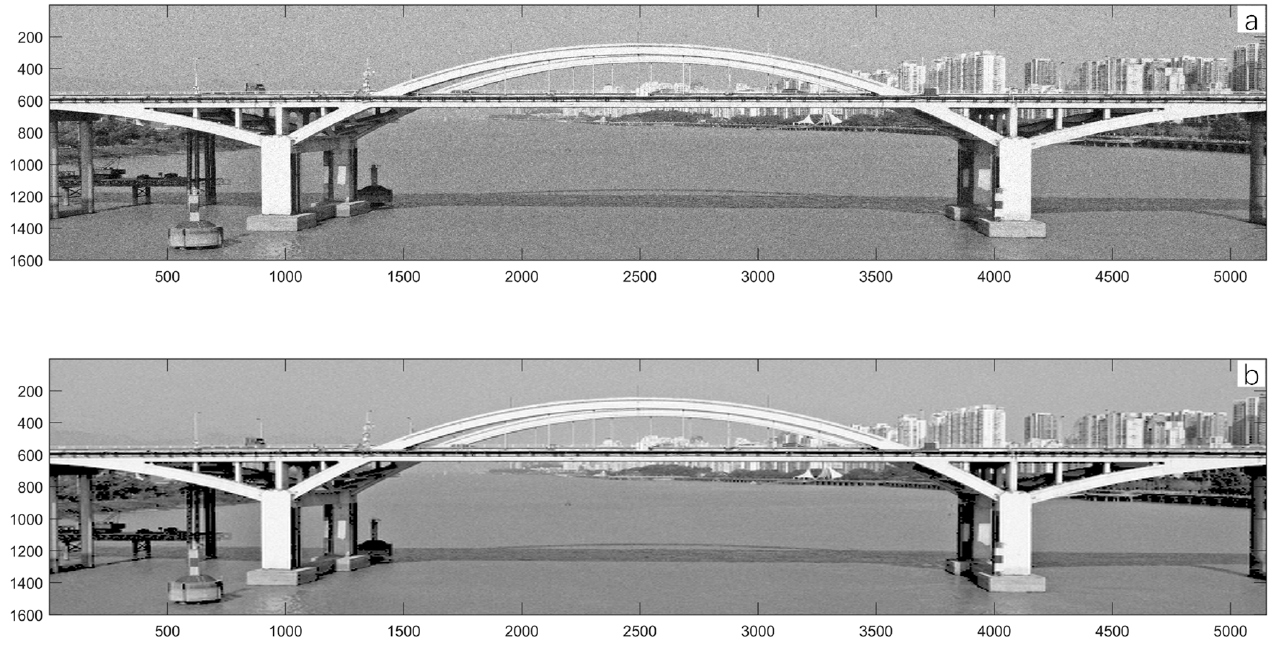
Figure 6. Image denoising: ( a ) noise-laden images; ( b ) denoised images.